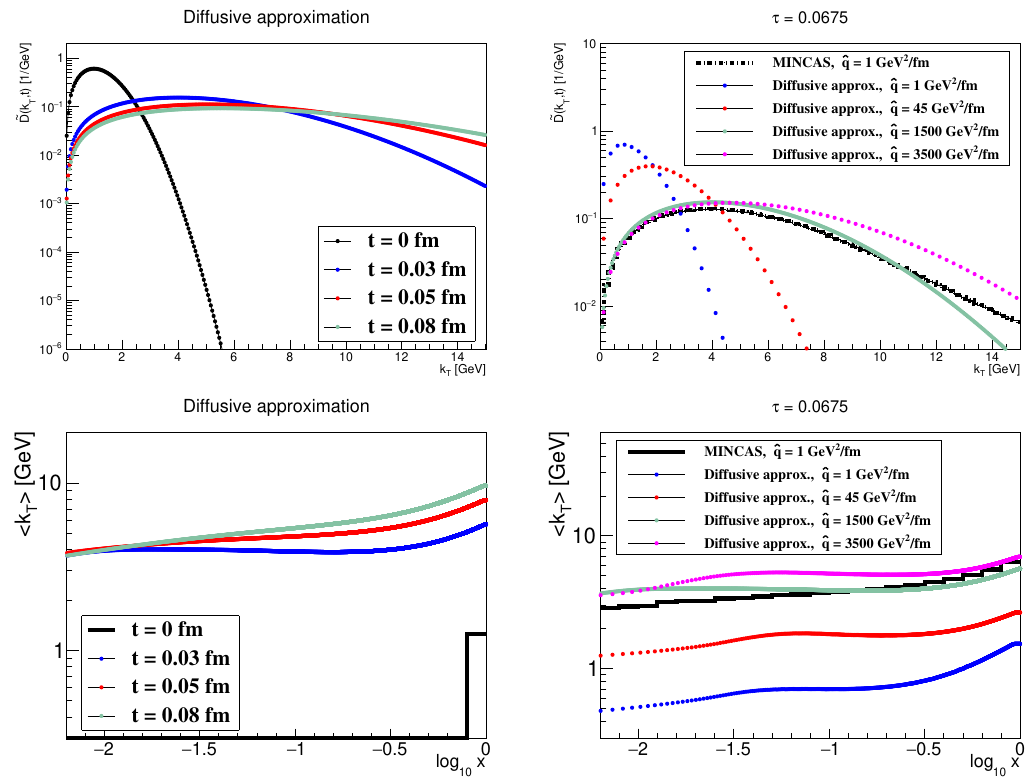
Figure 5 . The k T and h k T i vs. log x distributions for the diffusive approximation: for four values 10 of the evolution time t = 0 , 0 . 03 , 0 . 05 , 0 . 08 fm and ˆ q = 1500 GeV 2 /fm (left), and for different values of ˆ q compared with the MINCAS results for ˆ q = 1 GeV 2 /fm and t = 1 fm with the z -only dependent kernel K ( z ) and the collision term of eq. (2.6) (right). In the diffusive approximation σ k = 1 GeV 0 was used; note also that the evolution times for ˆ q = 1500 GeV 2 /fm are equal to t = 0 , 1 , 2 , 3 fm ( τ ≡ t/t ∗ = 0 . 0675 when t = 1 fm) in the case of ˆ q = 1 GeV 2 /fm.